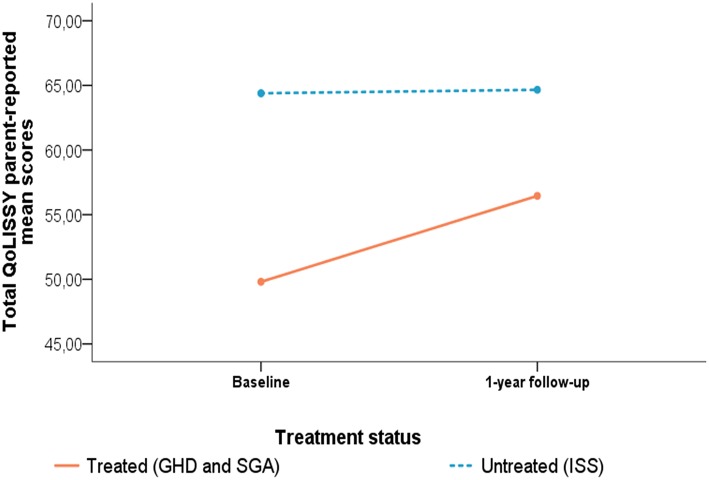
Changes in parent-reported QoLISSY Total score from baseline to 1-year after start of hGH treatment for the intervention group (patients with IGHD and SGA) and comparison group (untreated patients with ISS). Two-factorial repeated measurement ANCOVA for the QoLISSY Total score. Covariates appearing in the model were evaluated at the following values: age at baseline = 7.81 years; Time difference between baseline and 1-year follow-up = 12.45 months.